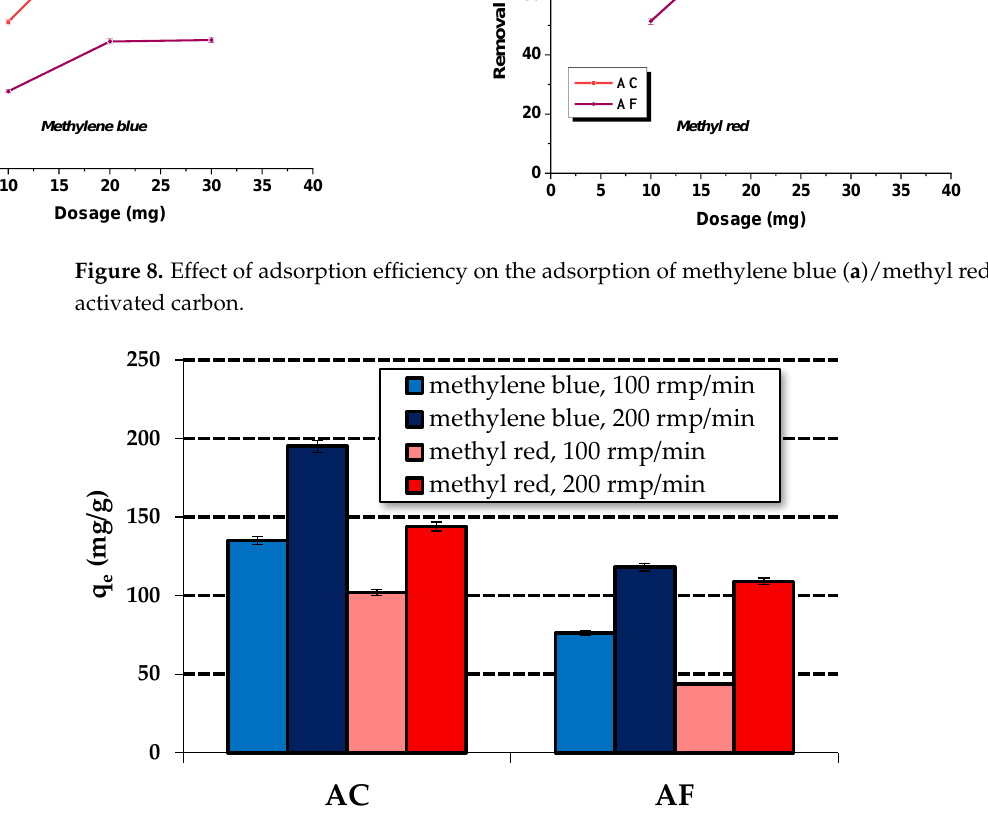
Figure 9. Effect of agitation rate on the adsorption of organic dyes on activated carbon.